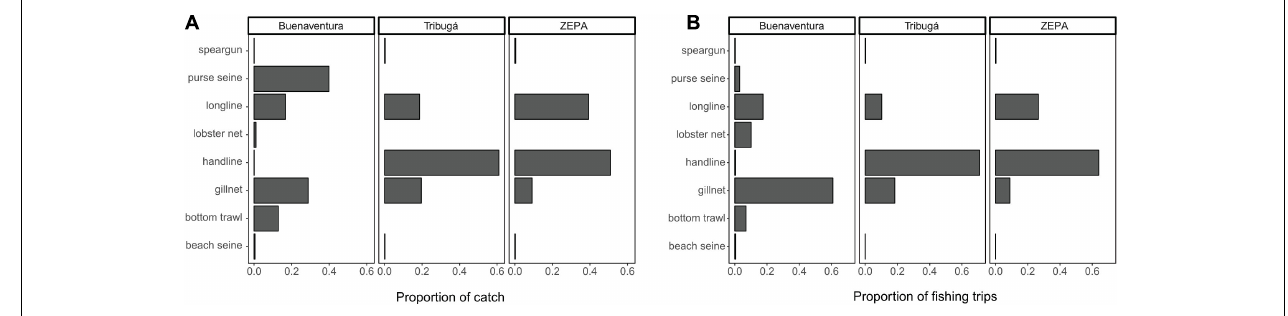
FIGURE 2 | Relative contribution to the catch in terms of biomass (A) and to the number of sampled fishing trips (B) by each gear type used in the SSF at three coastal zones of the Colombian Pacific. Sampling periods and landing sites included in each coastal zone are described in Section “Materials and Methods.”